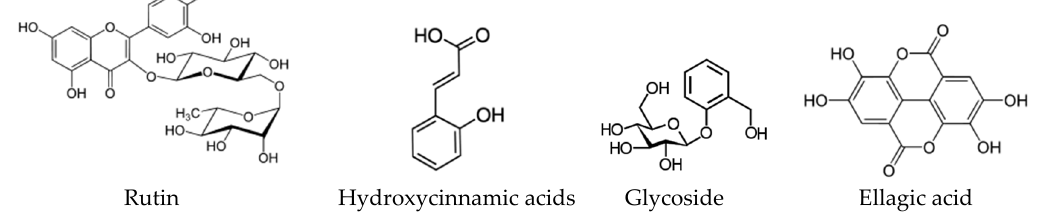
Figure 11. The major phenolic compounds that have been reported in stingless bee pollen